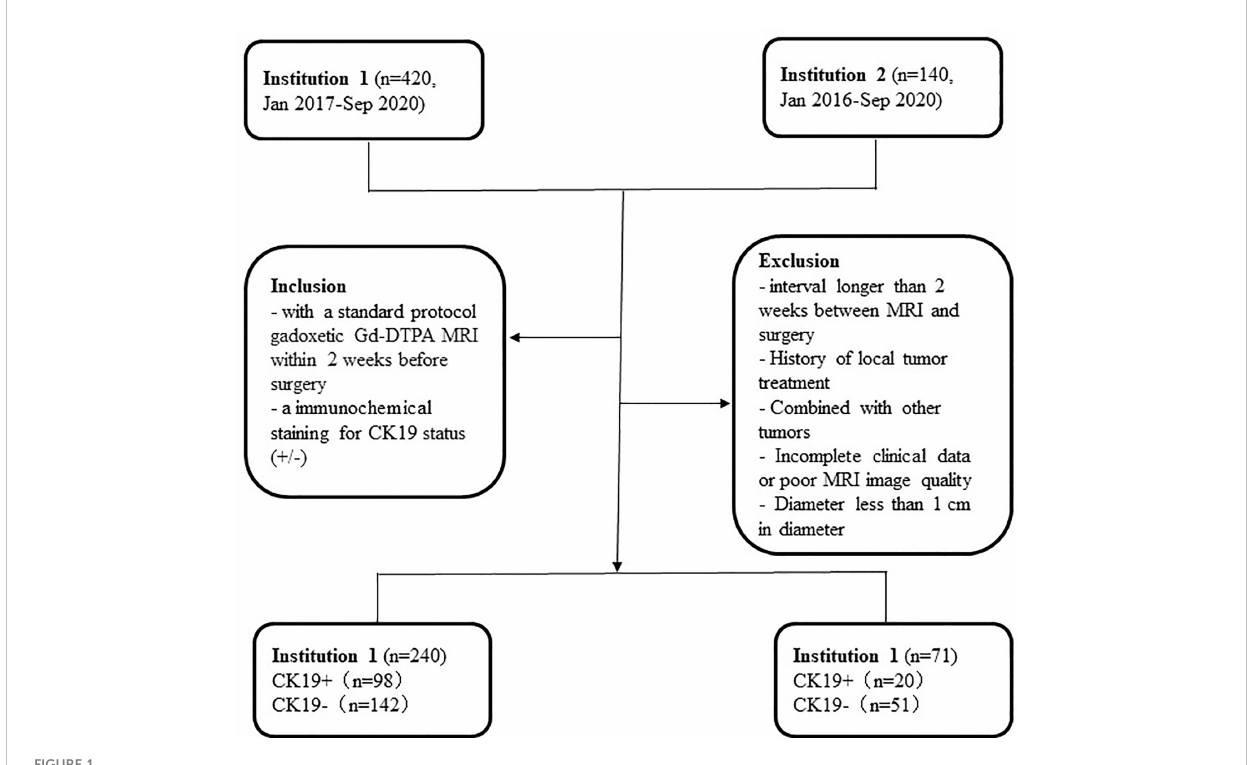
FIGURE 1 Flowchart of the present